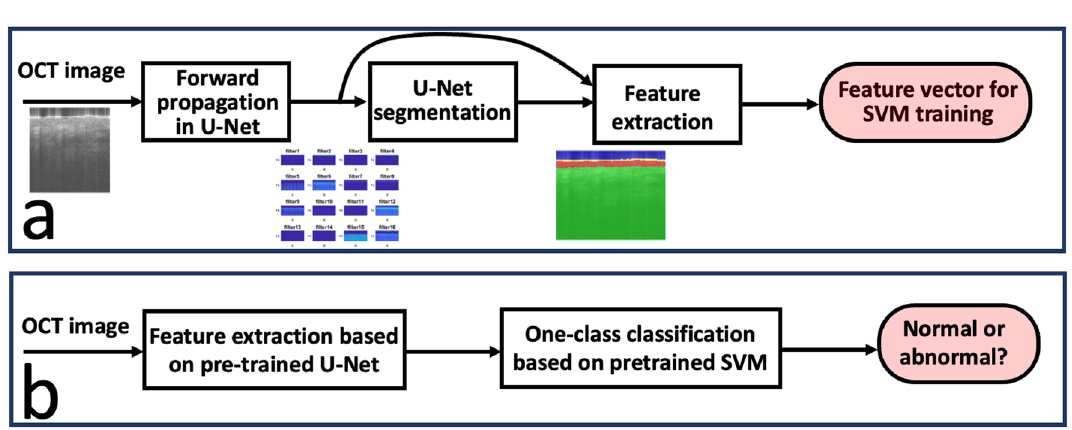
Figure 4. ( a ) Feature extraction using a pre-trained U-Net as a feature extractor; ( b ) classification of an input OCT image using one-class